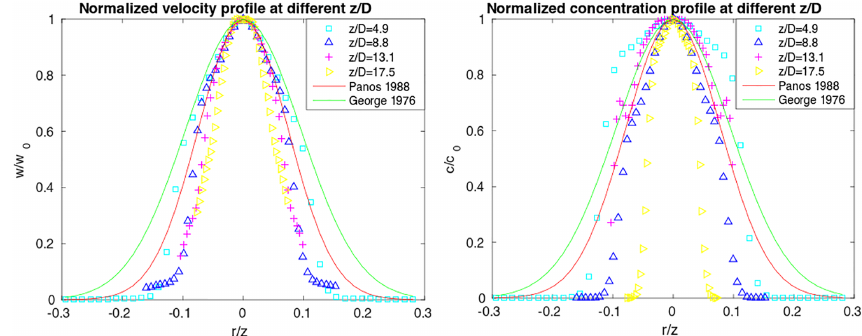
Figure 7. Dimensionless concentration and velocity distribution across the cross